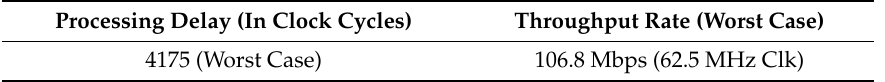
Table 2. Compression module processing delay and throughput rate (Assuming × MHz operating frequency).